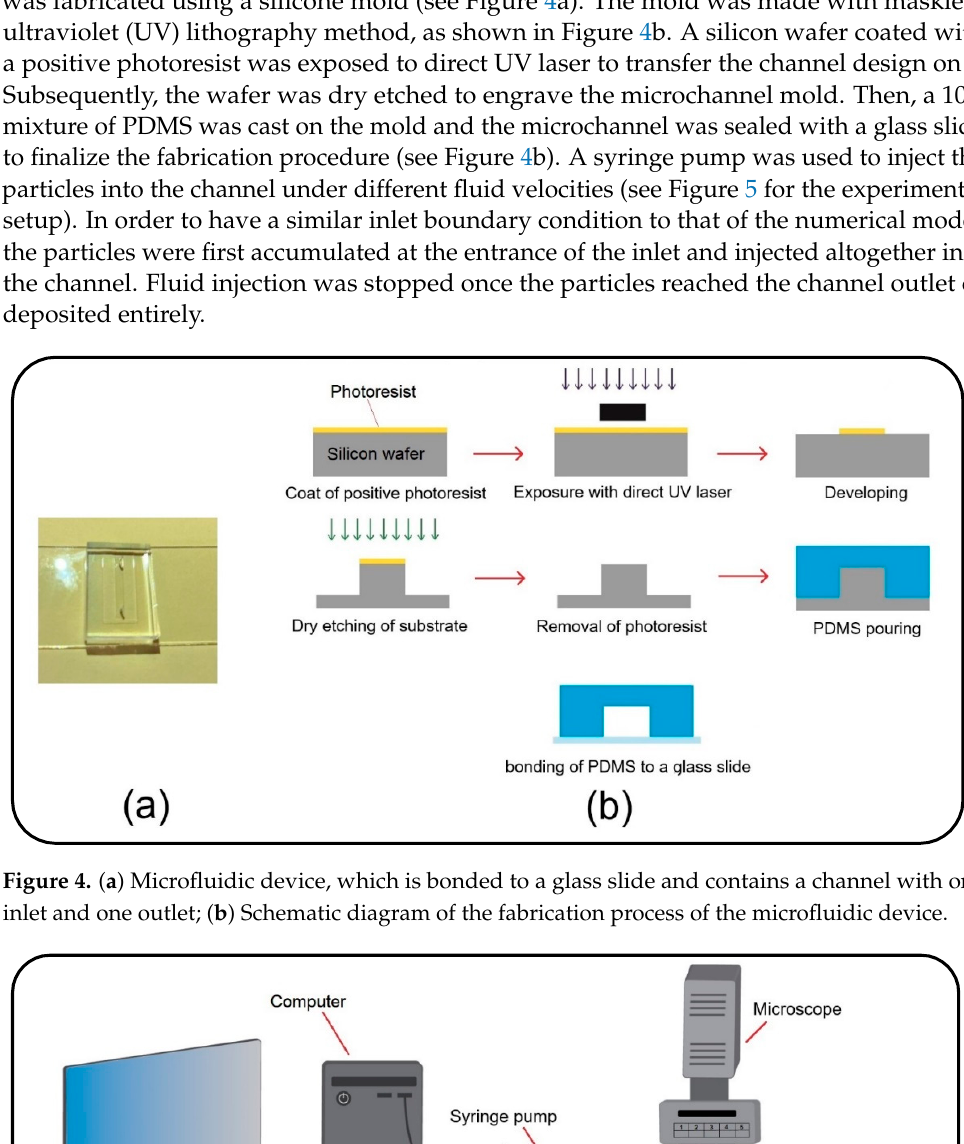
Table 1. The values of the parameter used for the experimental test.